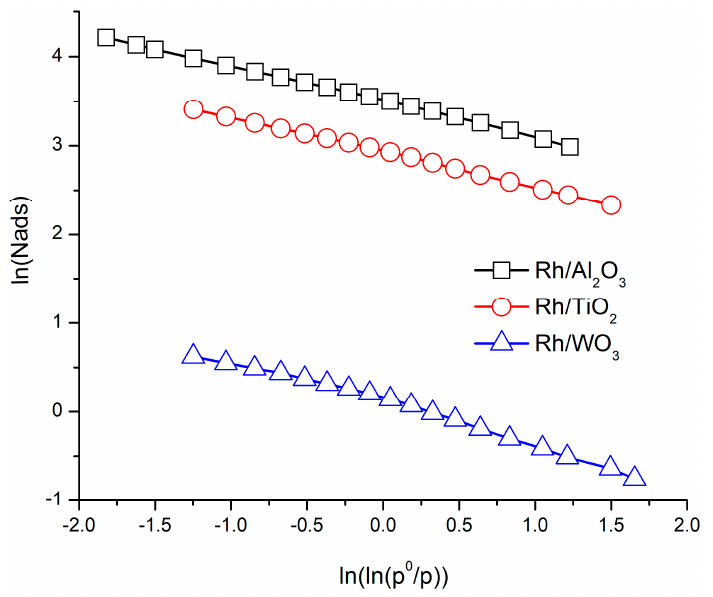
Figure 3. The fractal dimension determination from N 2 isotherms using Equation (21)—Fresh samples [28]. The slope of the log-log curves is -( D − 3)( D e − 3). Reprinted with permission from Ref. [28]. Copyright 2021 IOSR